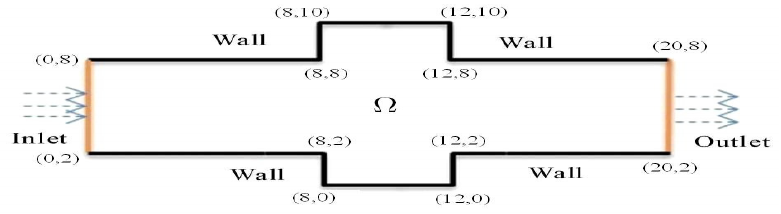
Figure 1. The computational field and boundary conditions of